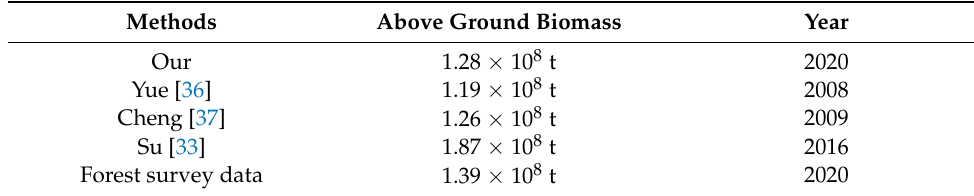
Table 5. Estimation results